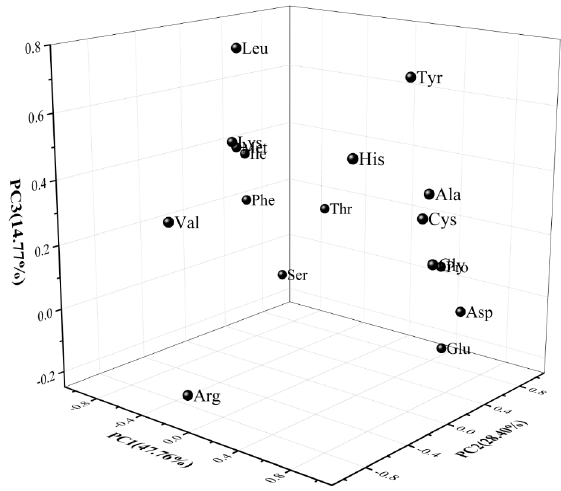
Figure 4. Results of the principal component analysis of the free amino acid attributes of fermented milk, showing the first three principal components (PC1, PC2 and PC3).